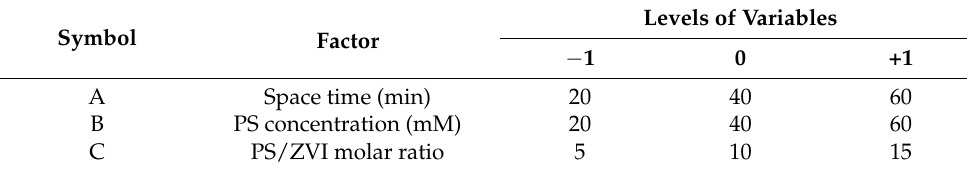
Table 6. Independent variables and their levels in continuous flow UV/PS/ZVI